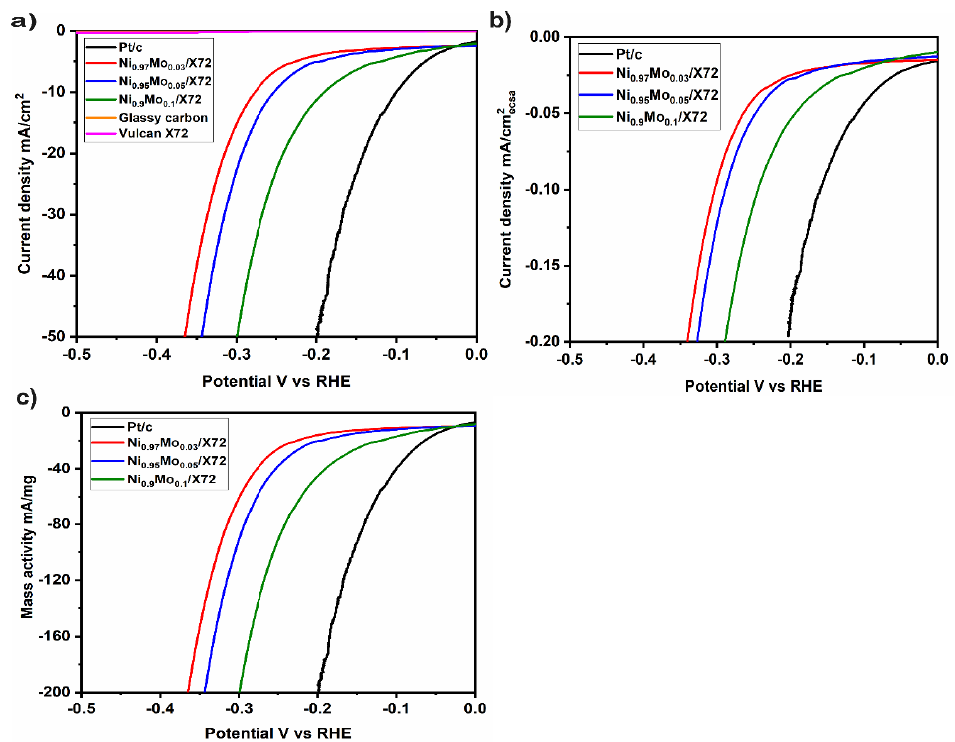
Figure 4. Linear sweep voltammetry (LSV) of NiMo with different Mo composition and Pt/C normalized to ( a ) geometric surface area and ( b ) electrochemical surface area and ( c ) mass loading.